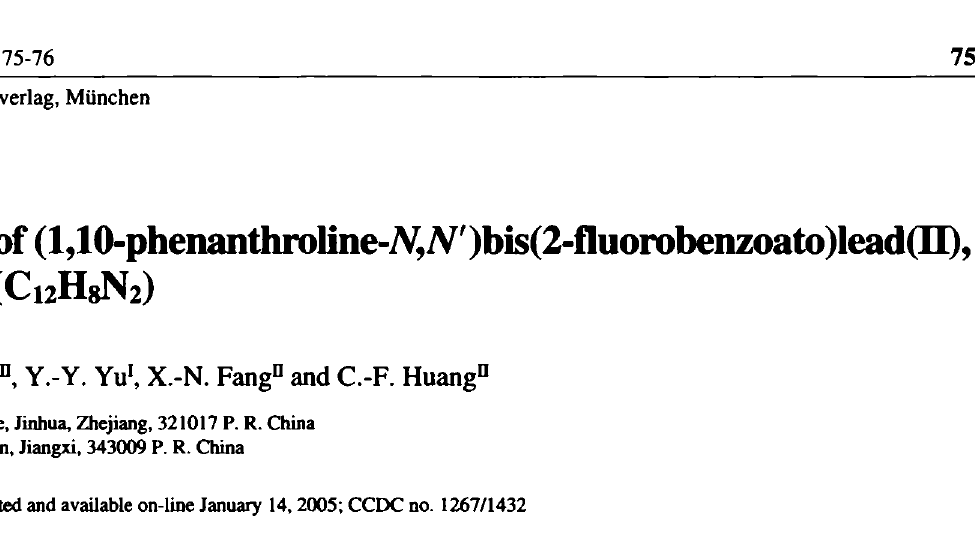
Table 1. Data collection and handling.